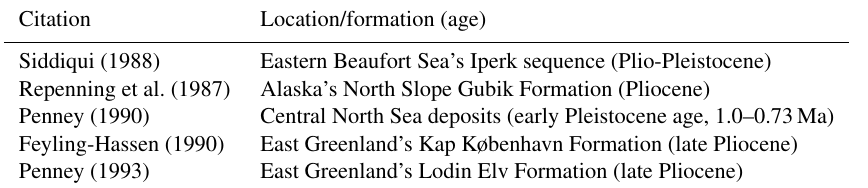
Table 5. Although R. mirabilis (Brady, 1868) is known and named from Pleistocene sediments in England and Scotland (Brady et al., 1874), this list cites various workers since that have documented this species in Arctic deposits dating back to the late Pliocene, when summer bottom temperatures were inferred to be up to 4 ◦ C warmer than